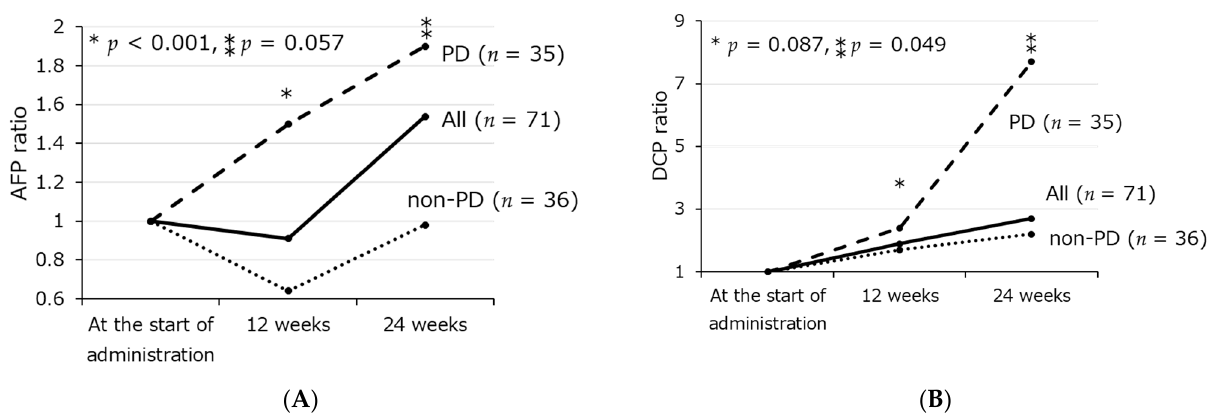
Figure 1. Transition of AFP ratio ( A ) and DCP ratio ( B ) from the start of administration to 24 weeks after administration according to treatment response using mRECIST. * Comparison of PD group and non-PD group at 12 weeks, ** Comparison of PD group and non-PD group at 24 weeks.